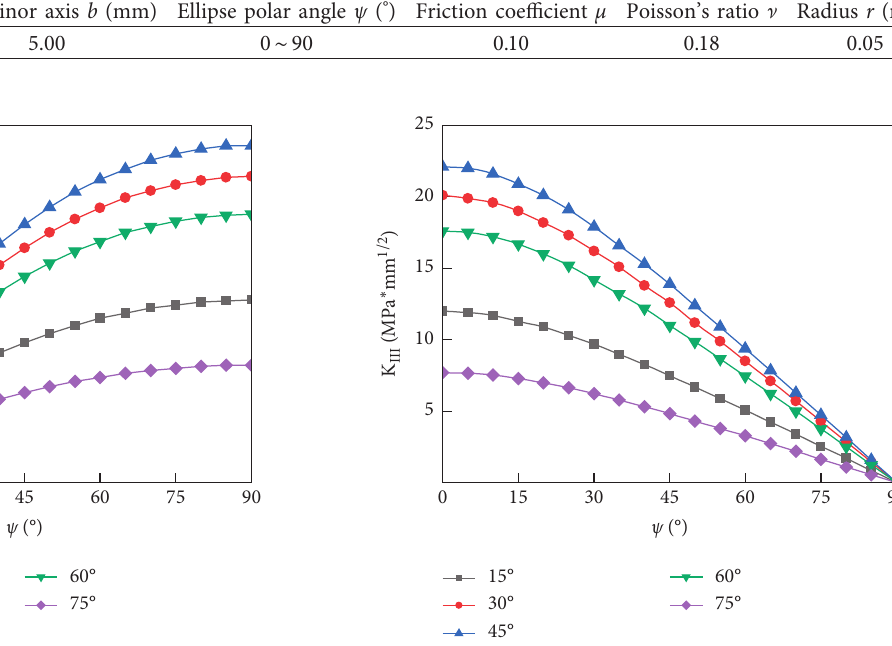
Figure 6: Variation of K II with elliptic polar angle ψ .